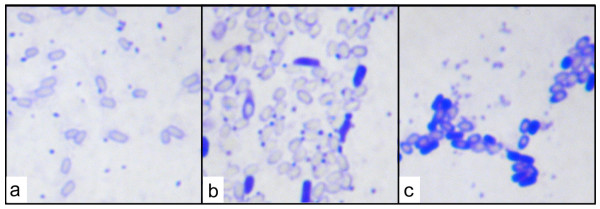
Relatively small parasporal bodies. Stained Brightfield micrographs (100X) of Bt1-22 (a), Bt1-40 (b) and Bt1-90 (c).